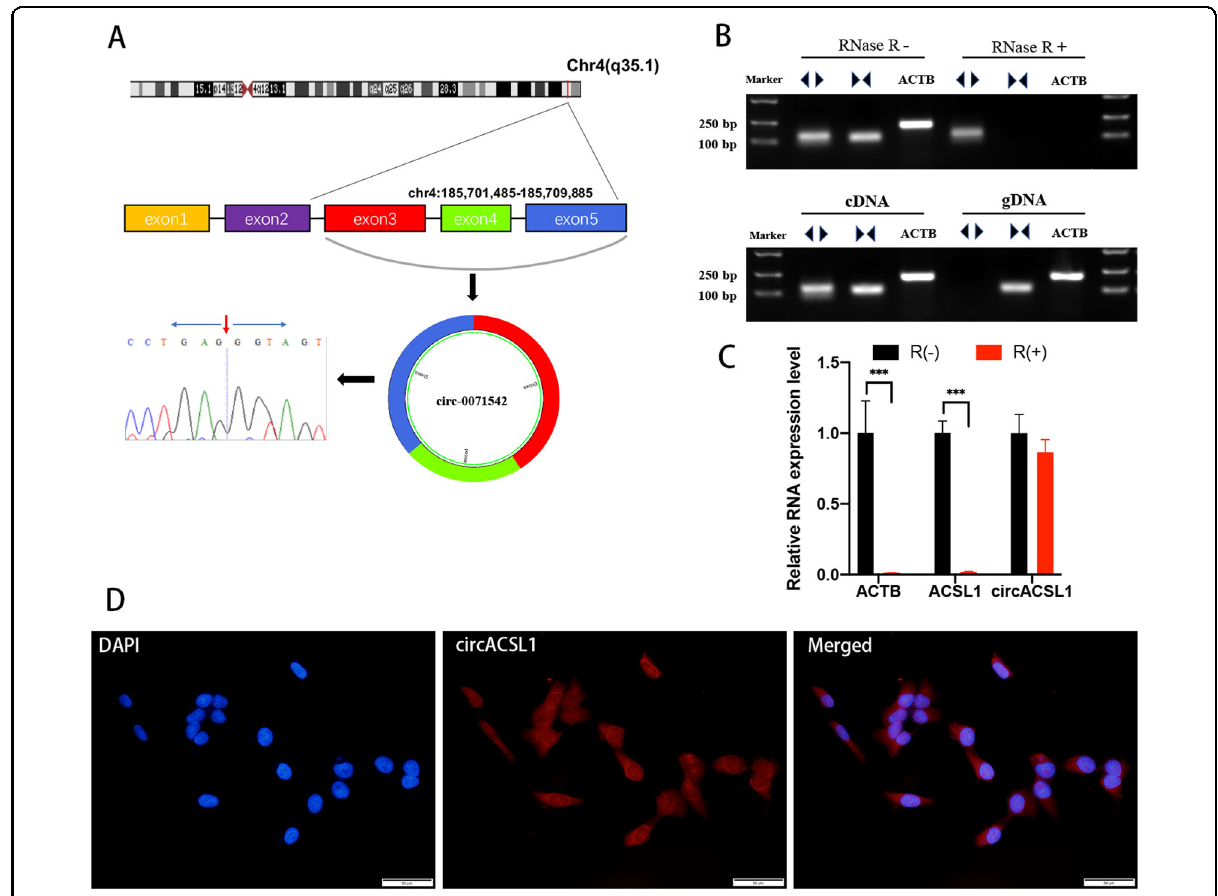
Fig. 1 Characteristics and subcellular localization of circACSL1. A The genomic loci of circACSL1 (hsa_circ_0071542) and schematic representation of circACSL1 formation. The expression of circACSL1 was validated by qRT-PCR using a spanning junction primer followed by Sanger sequencing. The red arrow represents head-to-tail circACSL1 splicing sites. B Northern blot analysis for the detection of circACSL1 expression in HCM treated with or without RNase R; divergent primers ampli fi ed circACSL1 from cDNA, but not from gDNA. ACTB was used as a negative control. C The expression of circACSL1 and ACSL1 mRNA in HCM cells treated with or without RNase R was detected by qRT-PCR. The relative levels of circACSL1 and ACSL1 mRNA were normalized to the values measured in RNase R-treatment group. * p < 0.05, *** p < 0.001. D RNA-FISH revealed the predominant localization of circACSL1 in the cytoplasm. circACSL1 probes were labeled with CY3 (red). Nuclei were stained with DAPI (blue). Scale bar, 50